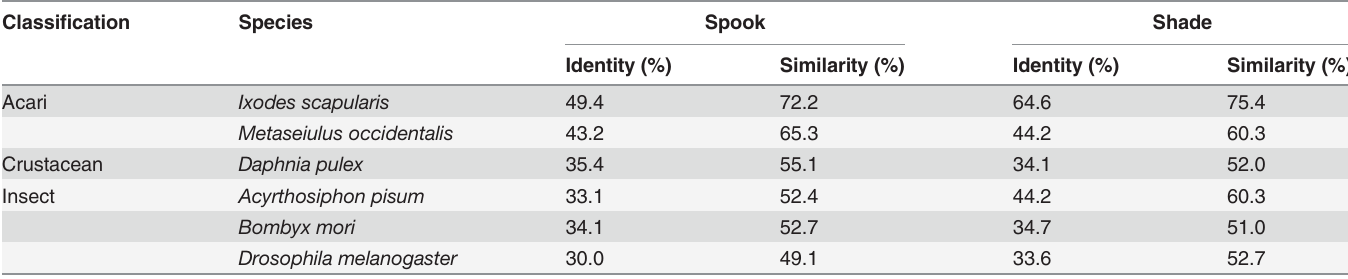
Table 2. Homologies of OmSpo and OmShd to their orthologs in other arthropods. Classi fi